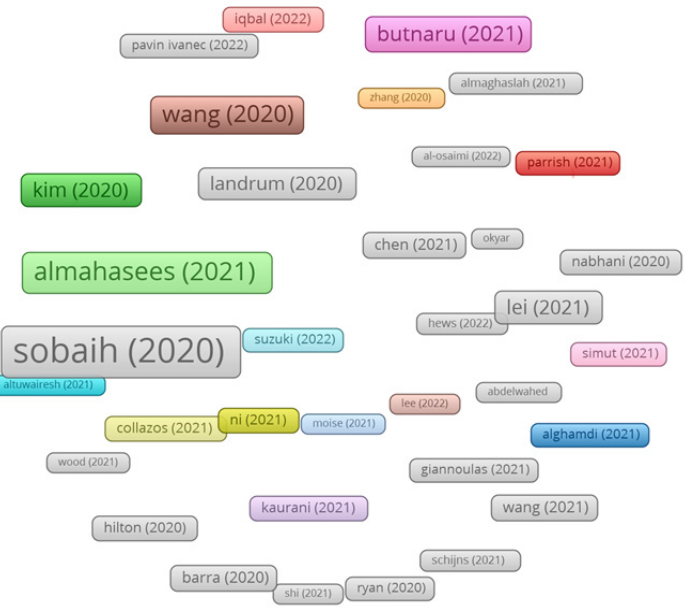
Figure 3. VOSviewer mapping of student perceptions of online education regarding citations. Source: authors’ own analysis with VOSviewer.